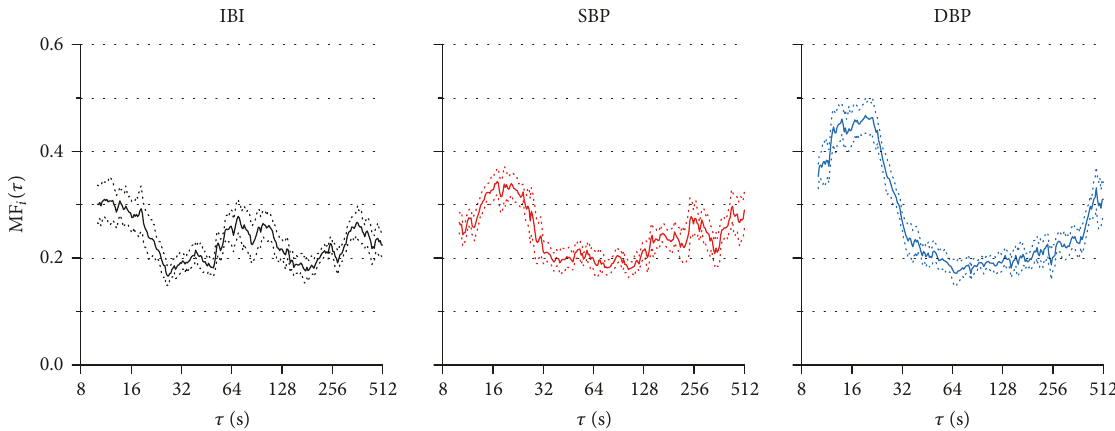
Figure 6: Multifractal index 𝑀𝐹 𝐼 (𝜏) for IBI, SBP, and DBP . Median ± standard error of the median over the group ( 𝑁 = 84 ).